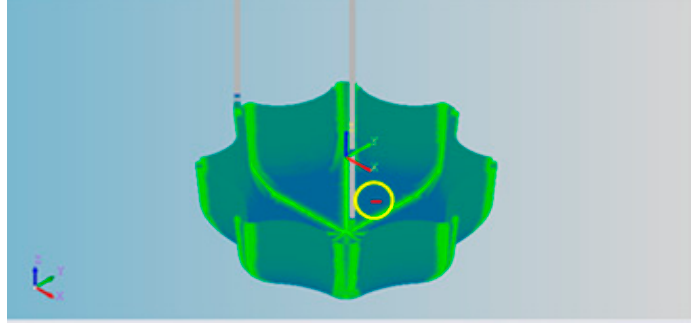
Figure 9. Visualization of the bottom of a Coke bottle.